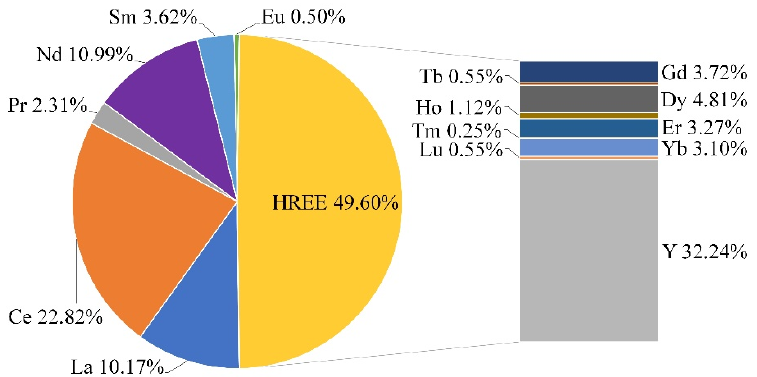
Figure 1. Distribution of individual rare earth elements in eudialyte ore sample.